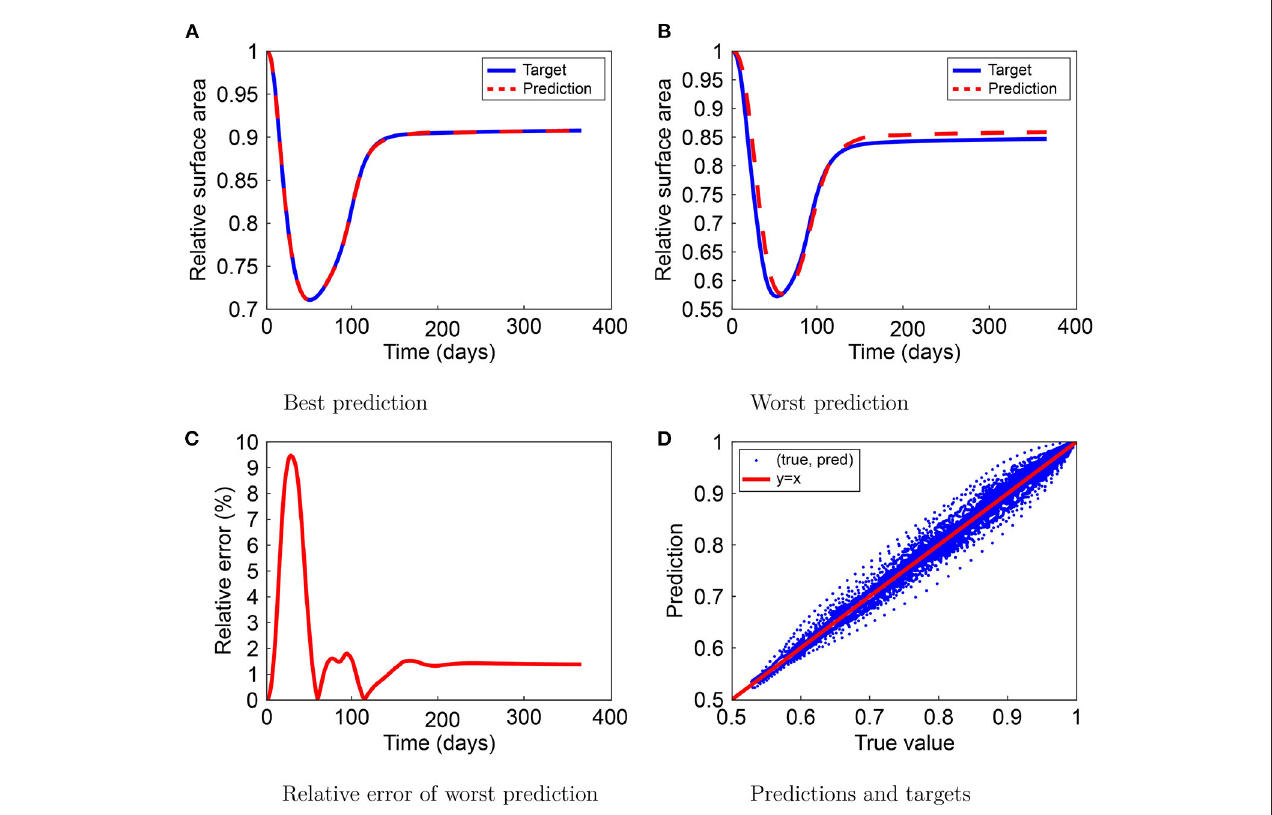
FIGURE2 Results for the relative surface area (RSA) prediction by the neural network. The figure shows the best (A) and worst (B) predictions, the worst prediction relative error (C) , and the prediction-target relation (D) .